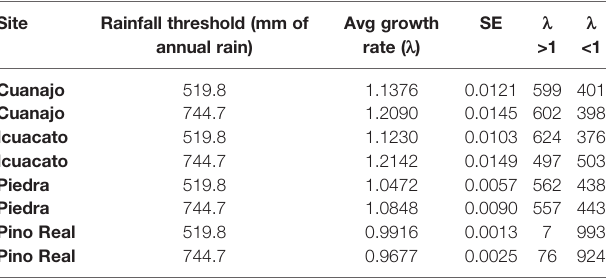
TABLE 7 | Growth rate values ( l ) (average, variation, and standard errors) in populations at different rainfall